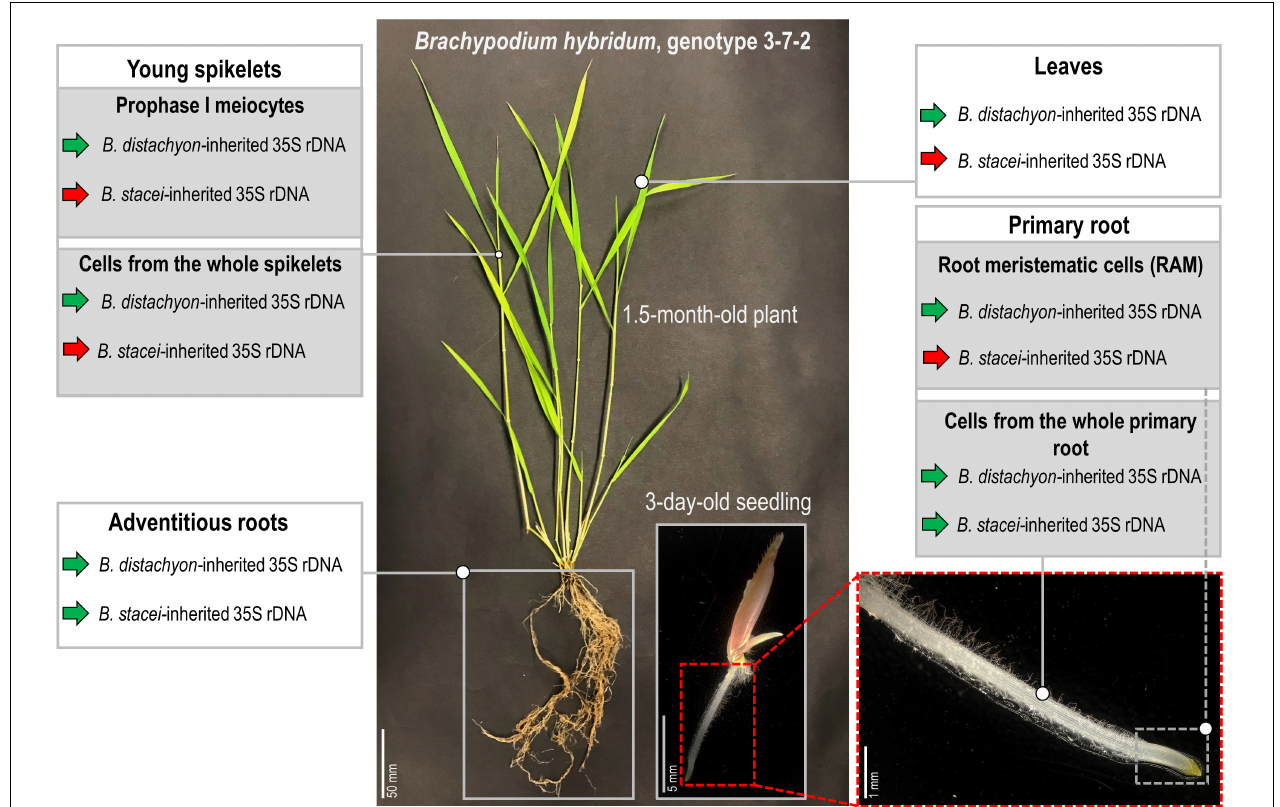
FIGURE 6 | Stability of the nucleolar dominance in different tissues of B. hybridum genotype 3-7-2. Green arrows denote the transcriptionally active 35S rDNA, while the red arrows indicate the silenced